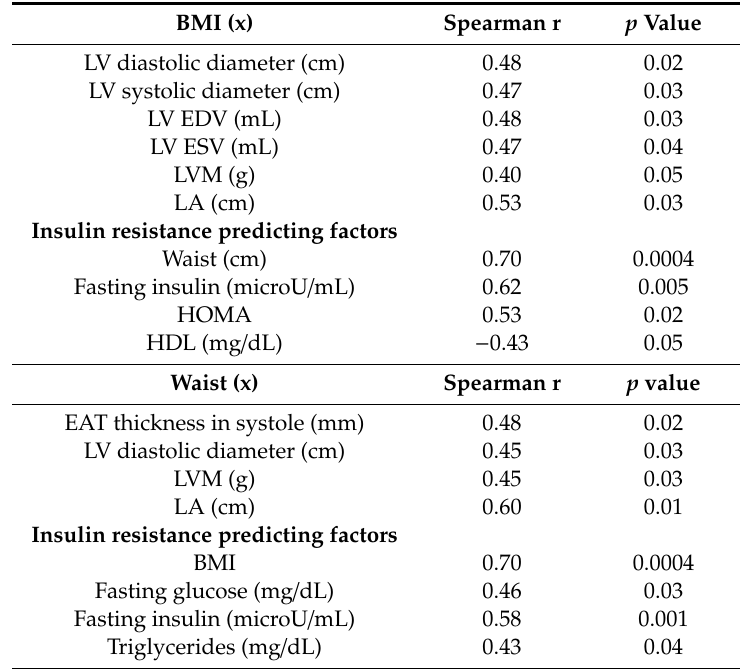
Table 3. Anthropometric measures of body fatness are associated with maladaptive heart remodeling in overweight CVD